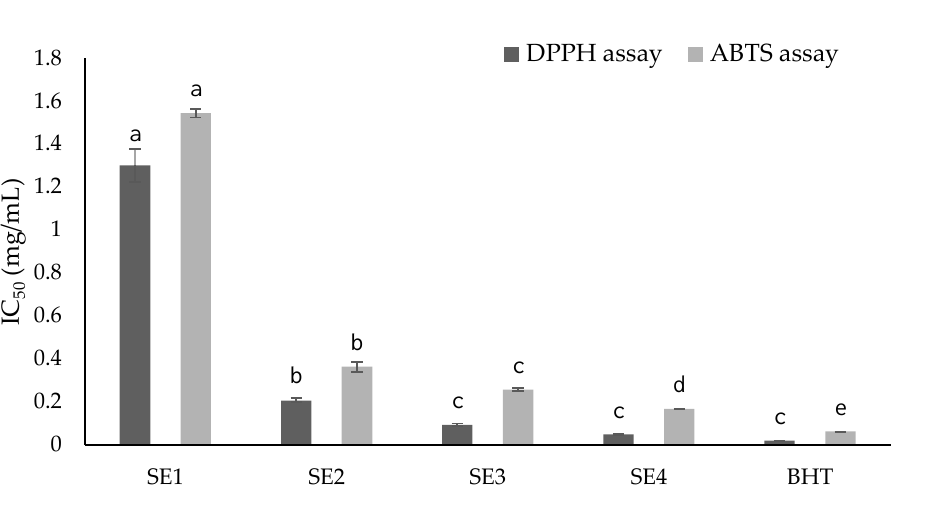
Figure 1. Antiradical activities of obtained fractions from SE extracts. Values enclosed with columns (same colors) followed by similar letters (a, b, c, d, e) indicate insignificant differences at p < 0.05.